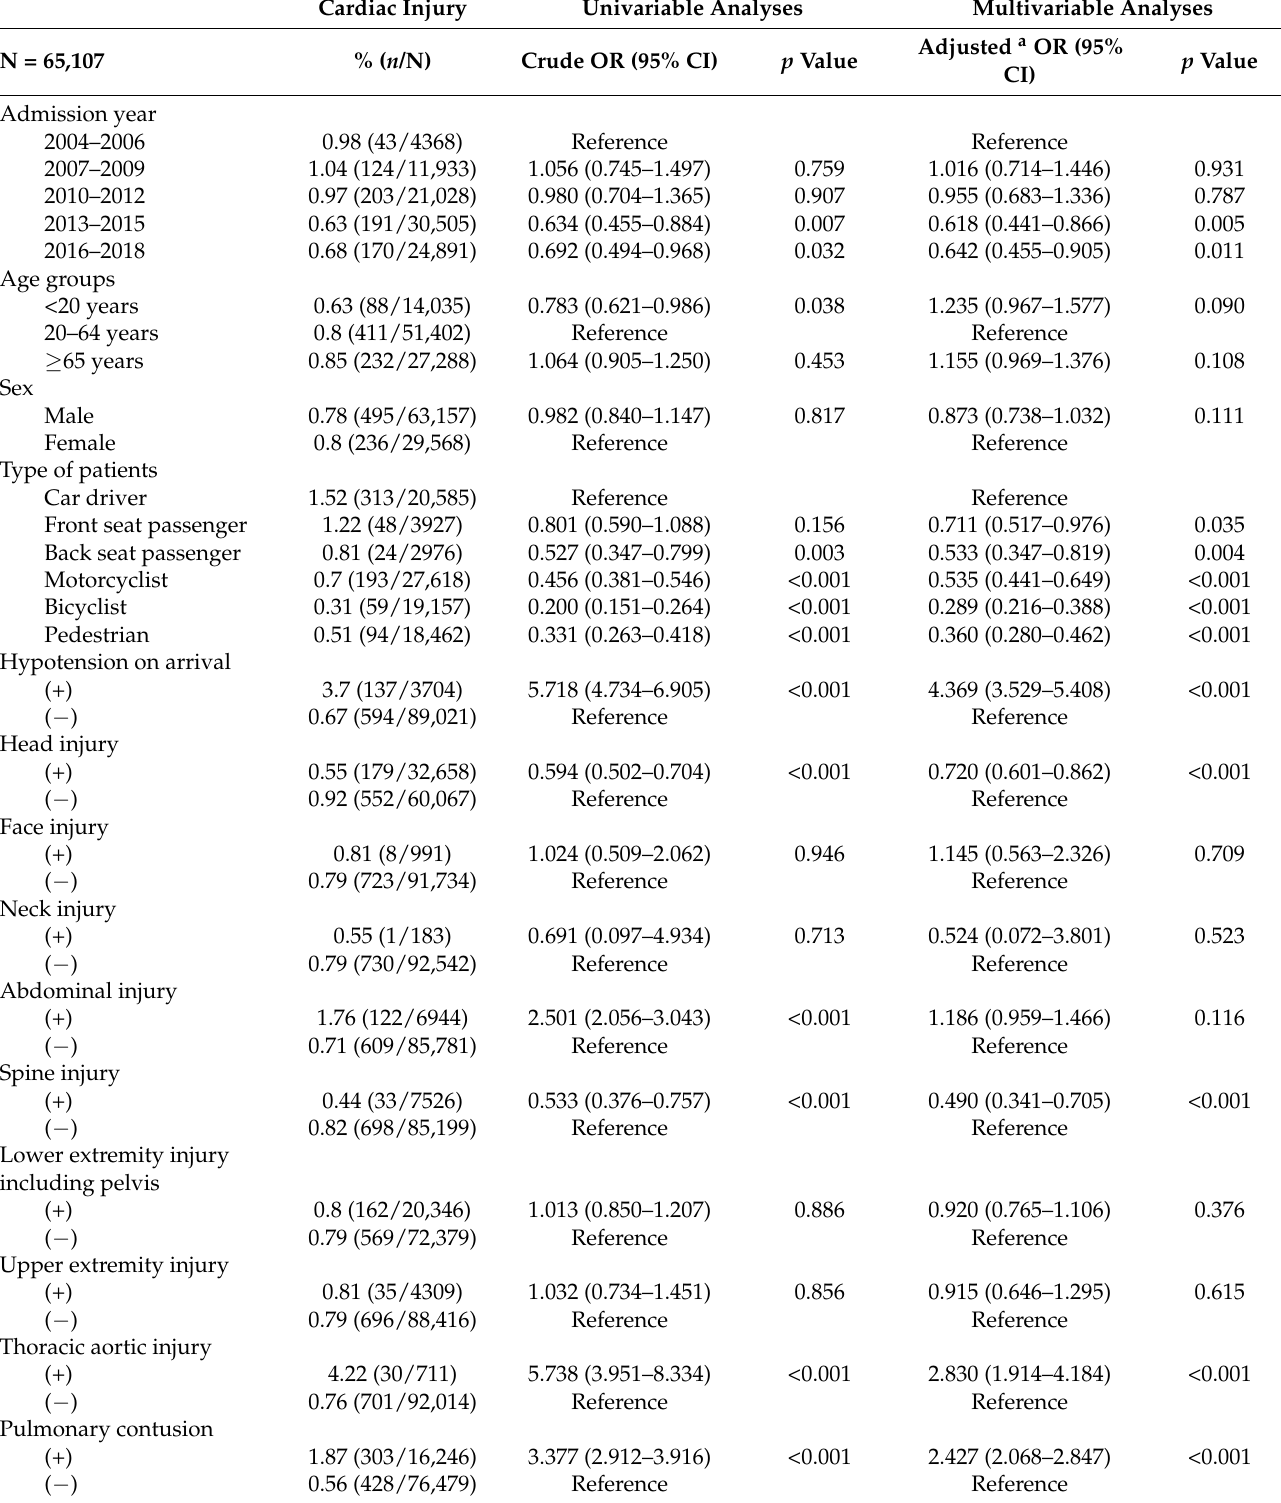
Table 3. Univariable and multivariable logistic regression to identify factors associated with cardiac injury among traffic accident patients (subgroup